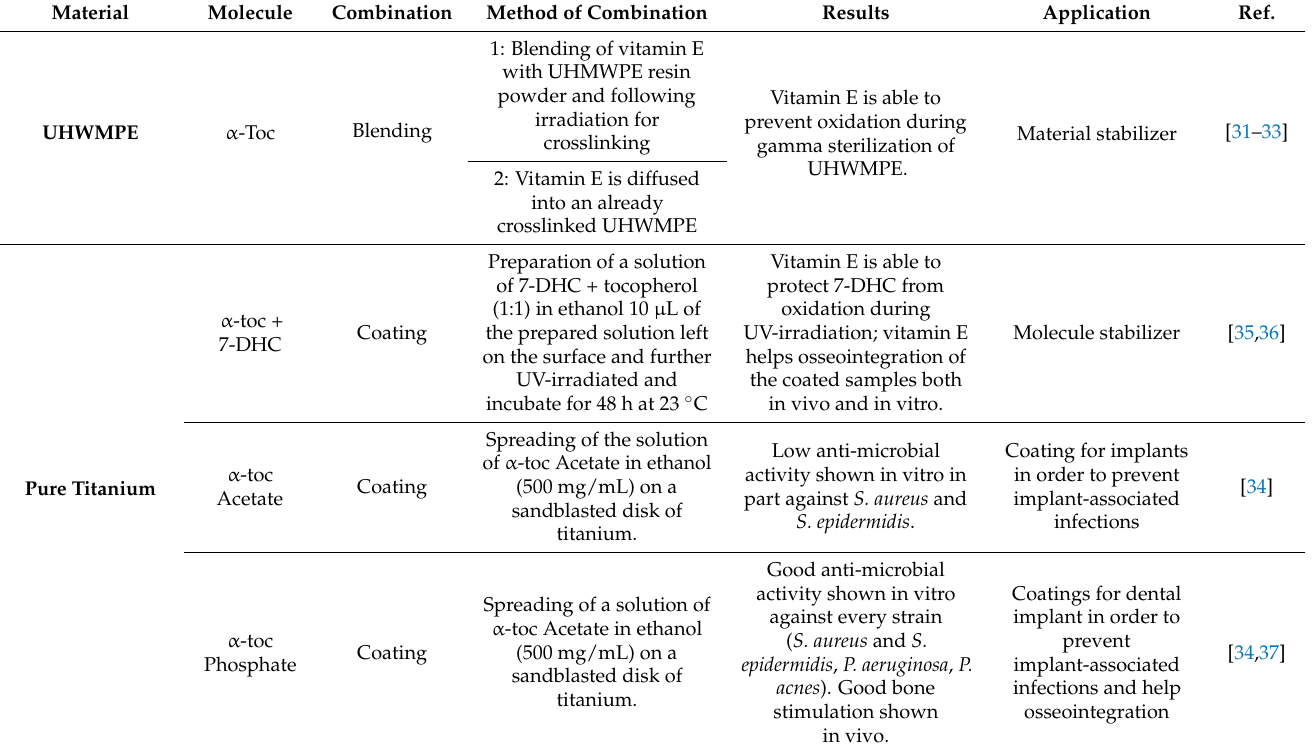
Table 1. Vitamin E in Prosthetic